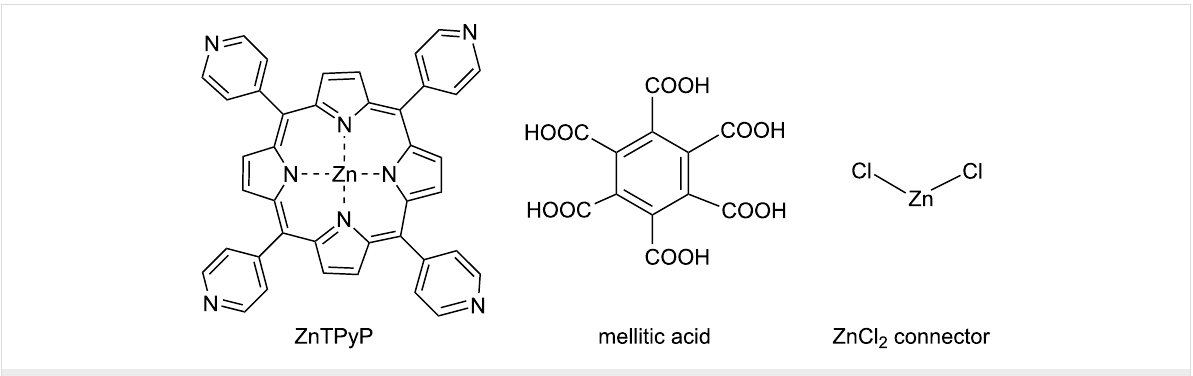
Scheme 1: Component building blocks of the supramolecular assembly in I and II